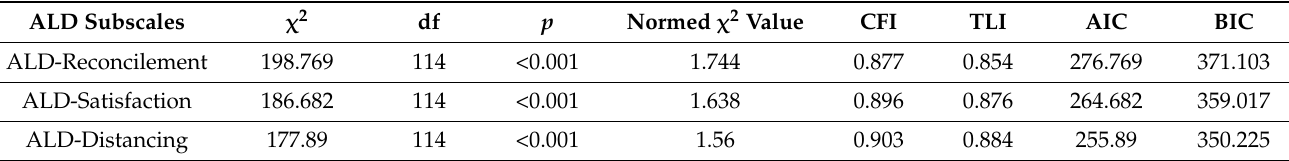
Table 3. Summary of the models and associated goodness-of-fit